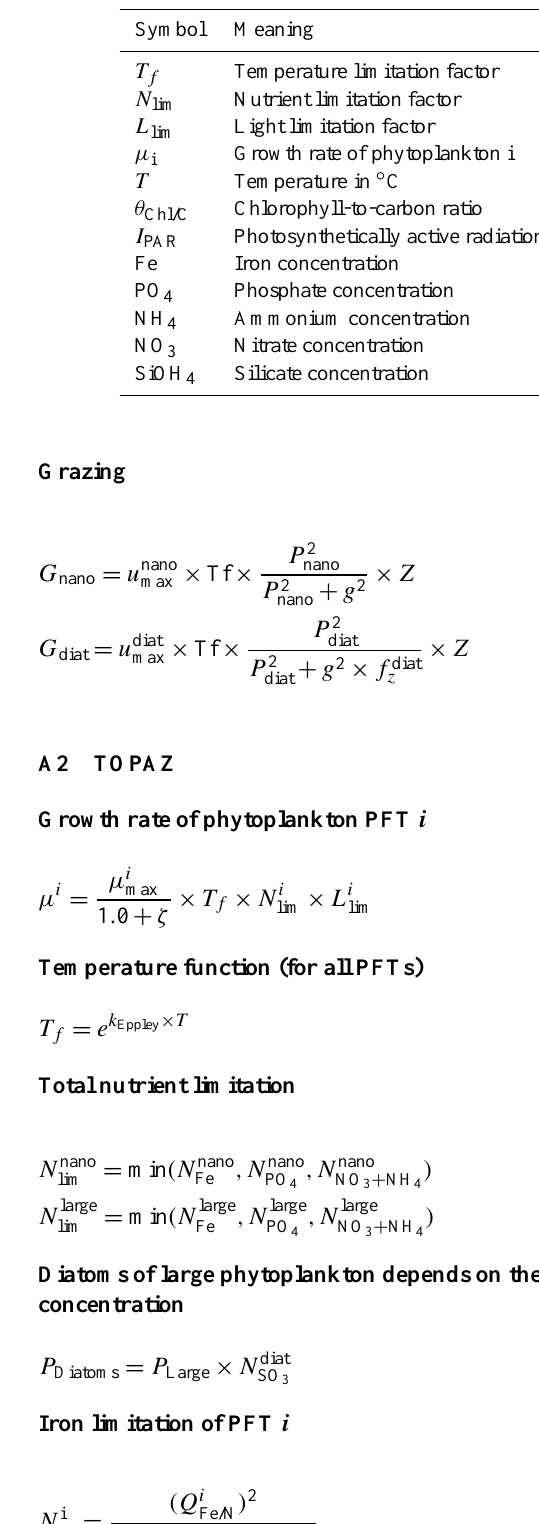
Table A1. Symbols used in the model